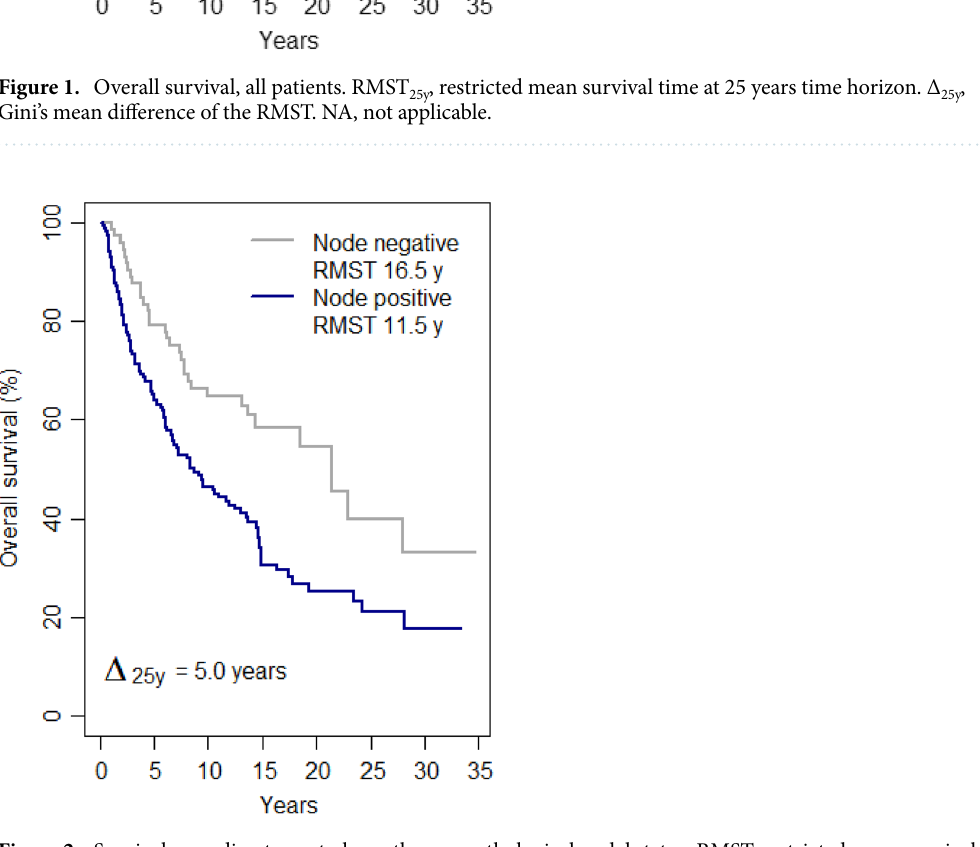
Figure 2. Survival according to post-chemotherapy pathological nodal status. RMST, restricted mean survival time at 25 years time horizon. Δ 25y , Gini’s mean difference of the